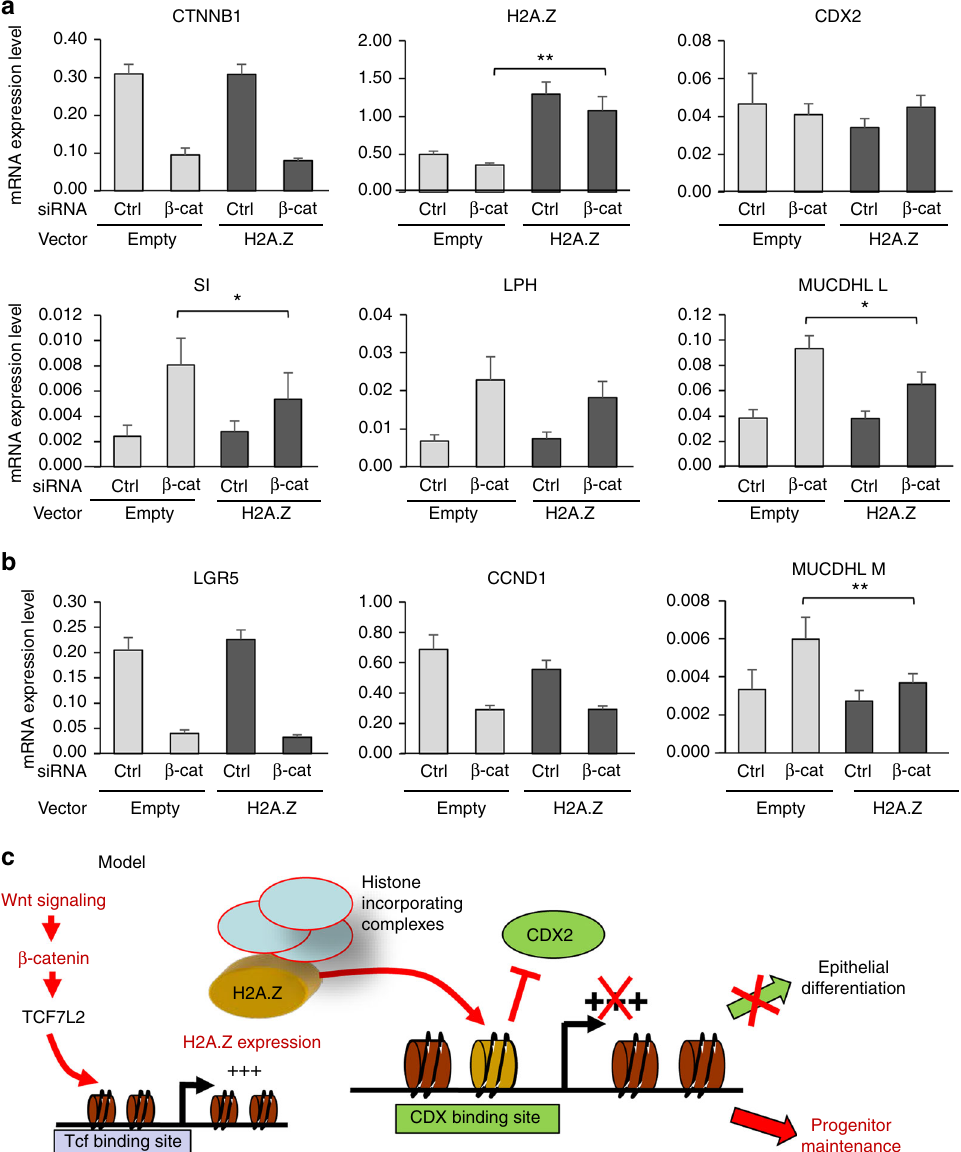
Fig. 9 H2A.Z is an effector of the Wnt pathway on differentiation markers. a Caco-2/15 were treated using siRNA targeting β -catenin mRNA or control and transfected with vectors encoding or not H2A.Z to analyse the impact of H2A.Z forced expression on the effects of β -catenin knockdown. The expression of the indicated genes was measured for each condition (calculated relative to β 2 M and RPLP0 (p0) mRNA levels). The mean and standard error are shown ( n = 6 independent experiments). Statistical analysis was done using Student ’ s t -Test (* p < 0.05; ** p < 0.02 vs β -catenin siRNA + empty